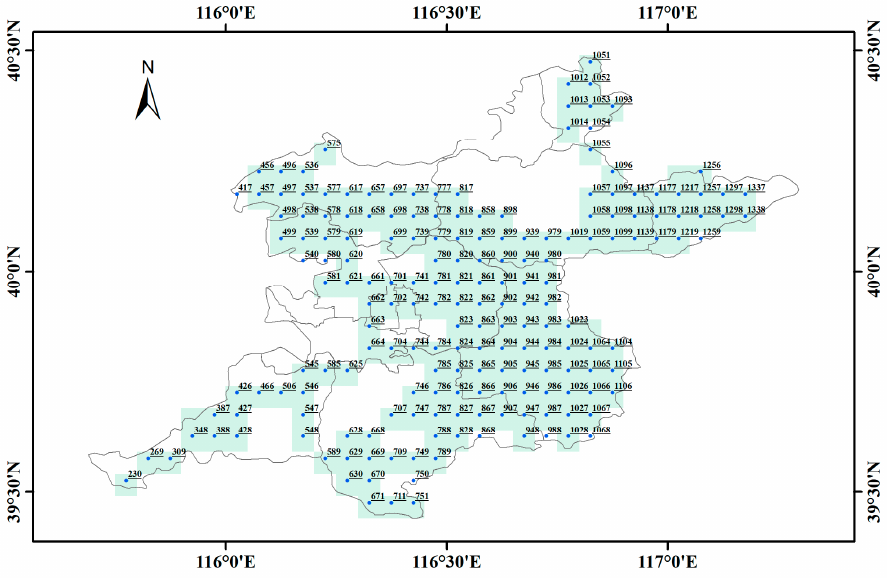
Figure 8. Sedimentation grids extracted from InSAR deformation.